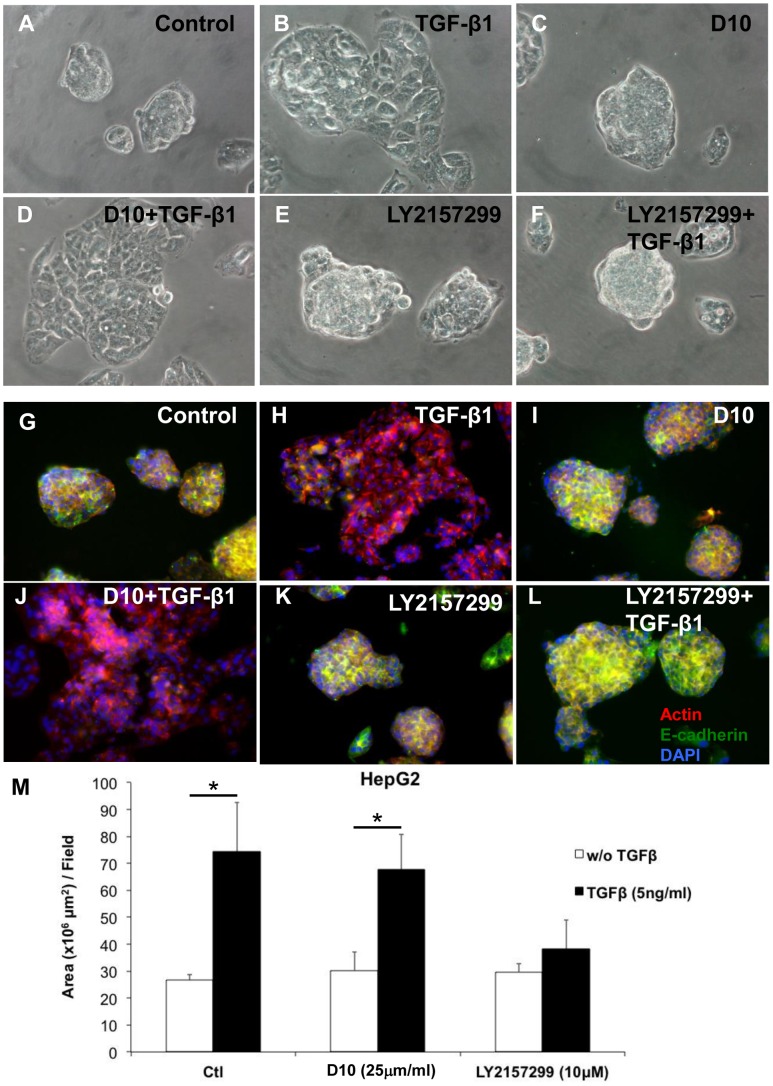
Comparison of the effect between LY2157299 and the fully humanized monoclonal antibody D10 on HCC cell morphology, actin cytoskeleton and E-cadherin expression.HepG2 cells were seeded onto glass coverslips at 3 x104 cells/ml in 24-well plates overnight and treated with control (A, G) or LY2157299 (E, K) or D10 (C, I) alone in serum-free medium. Then, cells were stimulated with TGF-β1 in the absence (B, H) or presence of LY2157299 (F, L) or D10 (D, J). LY2157299, D10 or TGF-β1 were added daily and after 72 hours cells were live-imaged under a phase contrast microscope. For immunofluorescence, cells were fixed with 4% paraformaldehyde, stained with TRITC-phalloidin and anti-E-cadherin antibody and examined under a NIKON eclipse E1000 fluorescence microscope. (M) Cell area was quantified using a combination of two digital image analysis softwares (ImageJ and Adobe Photoshop) and results were plotted as cell area (µm2) per random field.**P<0.01.